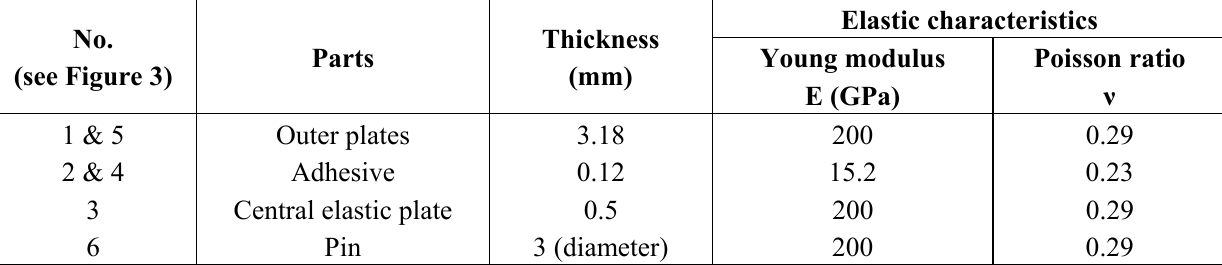
Table 1. The thickness of the sensor module components and their elastic